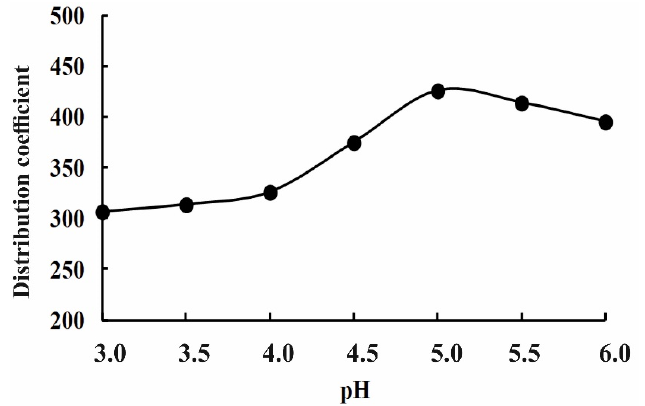
Figure 6. Samarium (III) cations’ distribution coefficients as a function of solution pH.